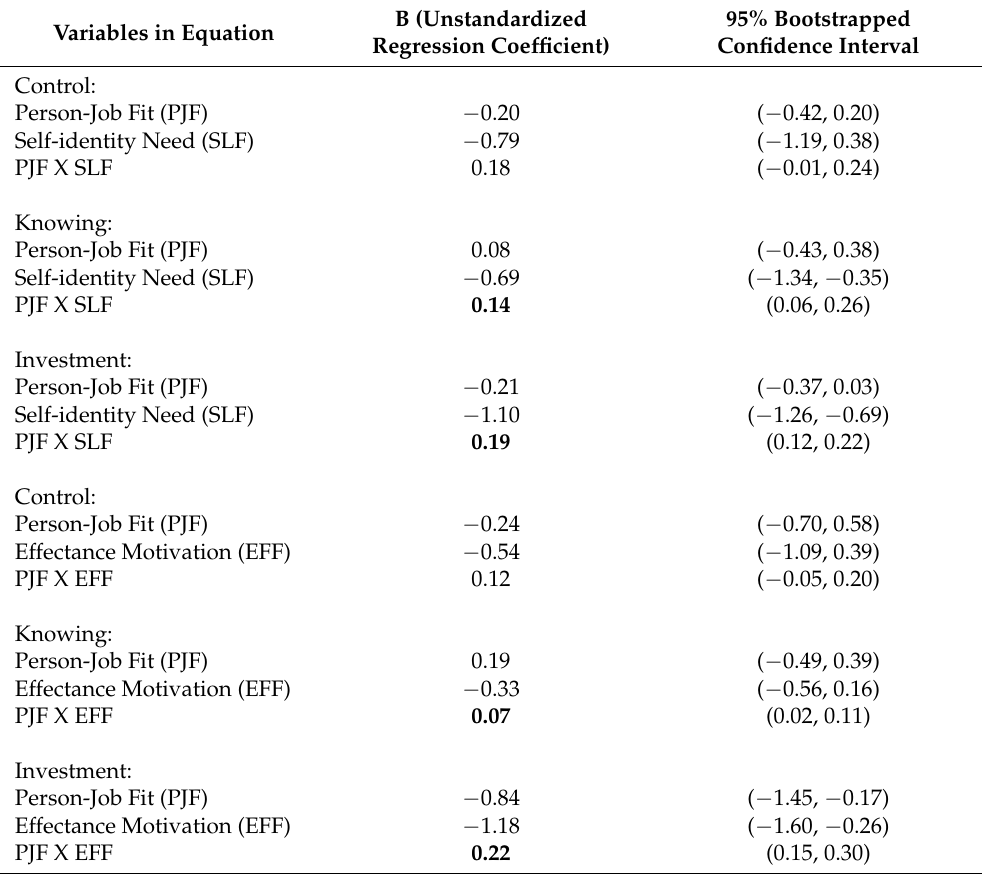
Table 3. Results from tests of moderated mediation hypotheses.